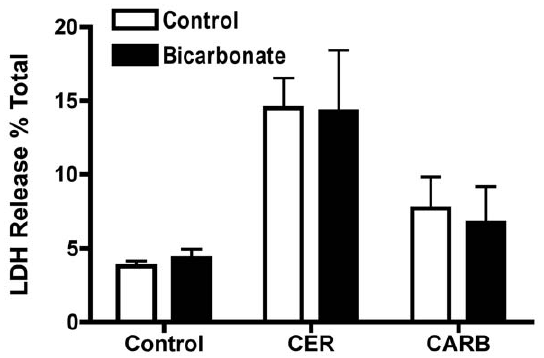
Figure 12. Bicarbonate treatment has no effect on secreta- gogue stimulated LDH release. Acini were treated with or without bicarbonate (25 mM) either alone or in the presence of either CER 100 nM or CARB 1 mM for 2 hours. Cells were collected and a cell free fraction obtained. Both the cell-free and cell-containing fractions were assayed for LDH and the results expressed as the percentage of LDH released into the media. (n $ 3).